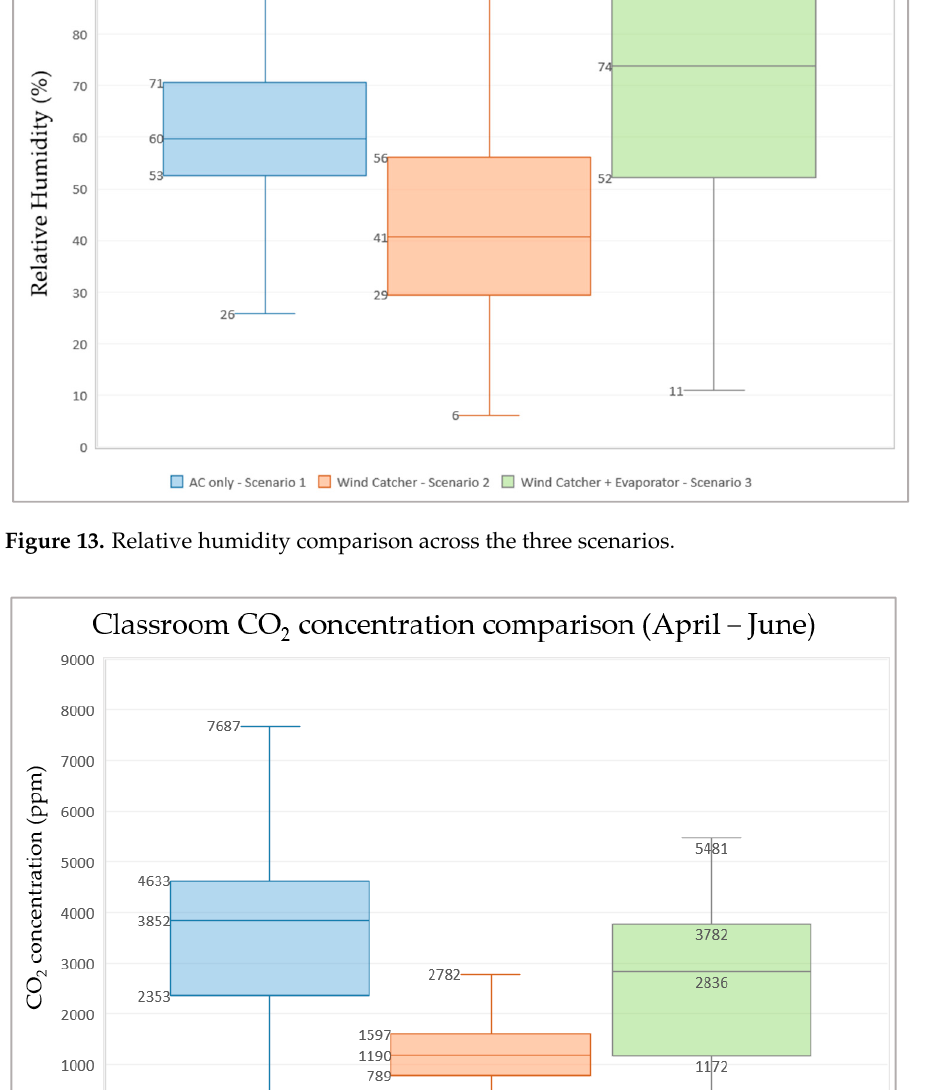
Figure 14. CO 2 concentration comparison across the three scenarios.